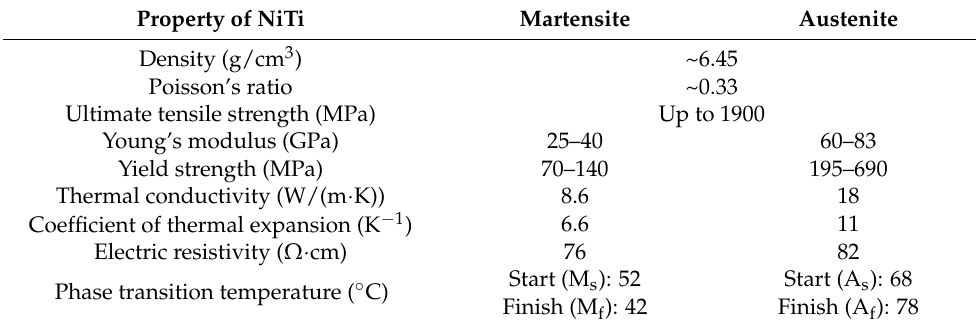
Table 2. Mechanical and physical properties of NiTi SMA